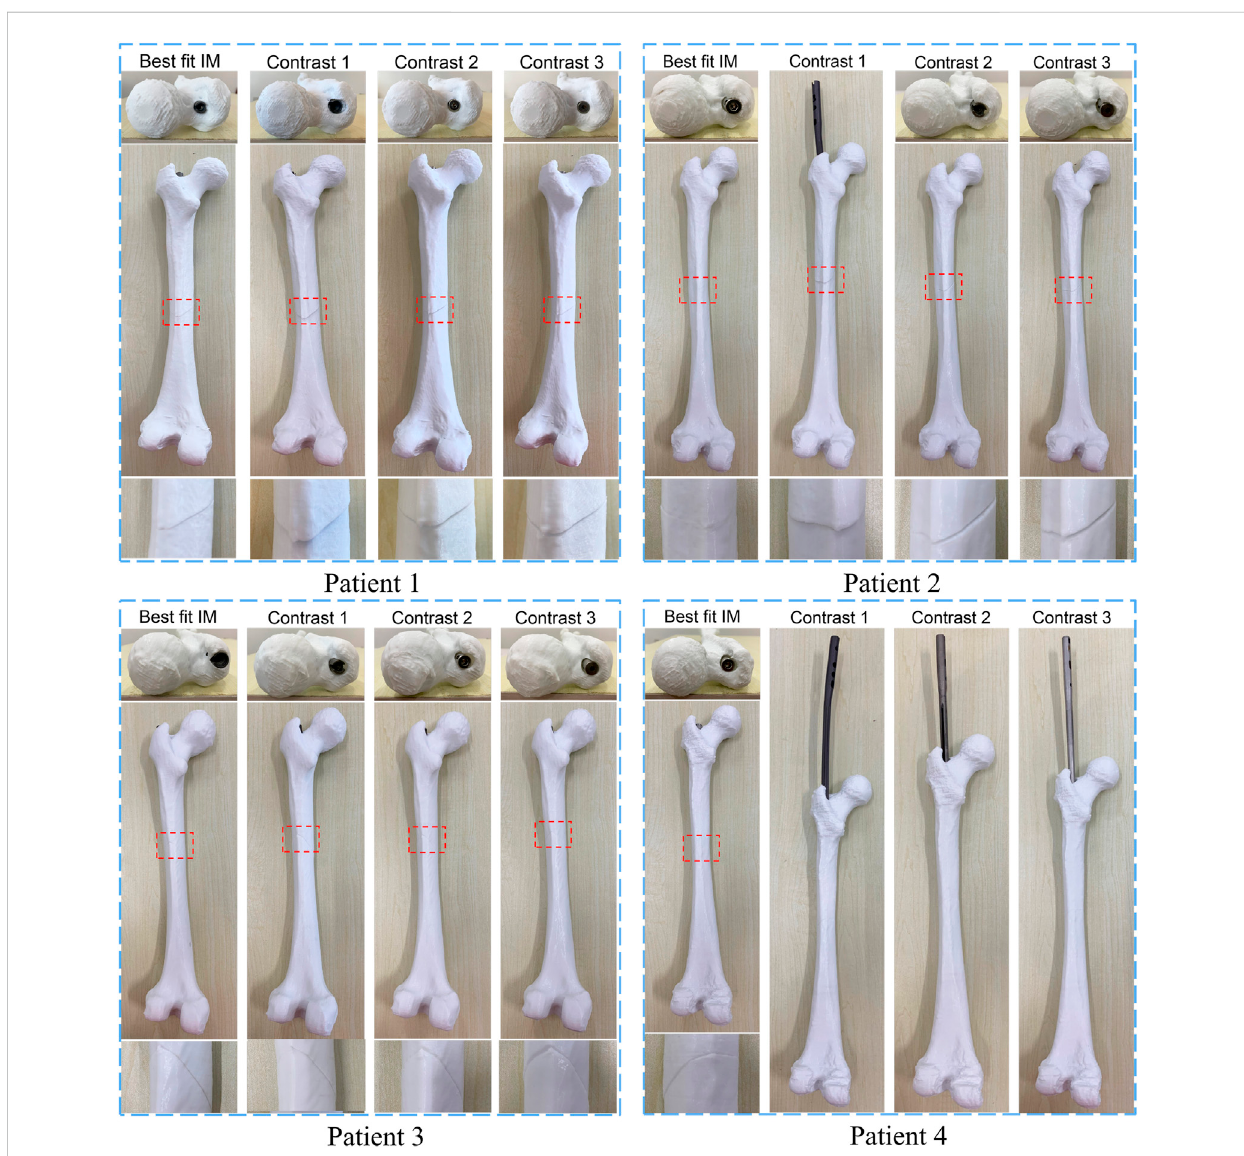
FIGURE 10 The result of matching experiments of intramedullary nails. The upper layer is the top view, and the alignment of the entry point and the intramedullary nail head is observed. The middle layer is a sagittal view, and the lower layer is a magni fi ed view of the crack.